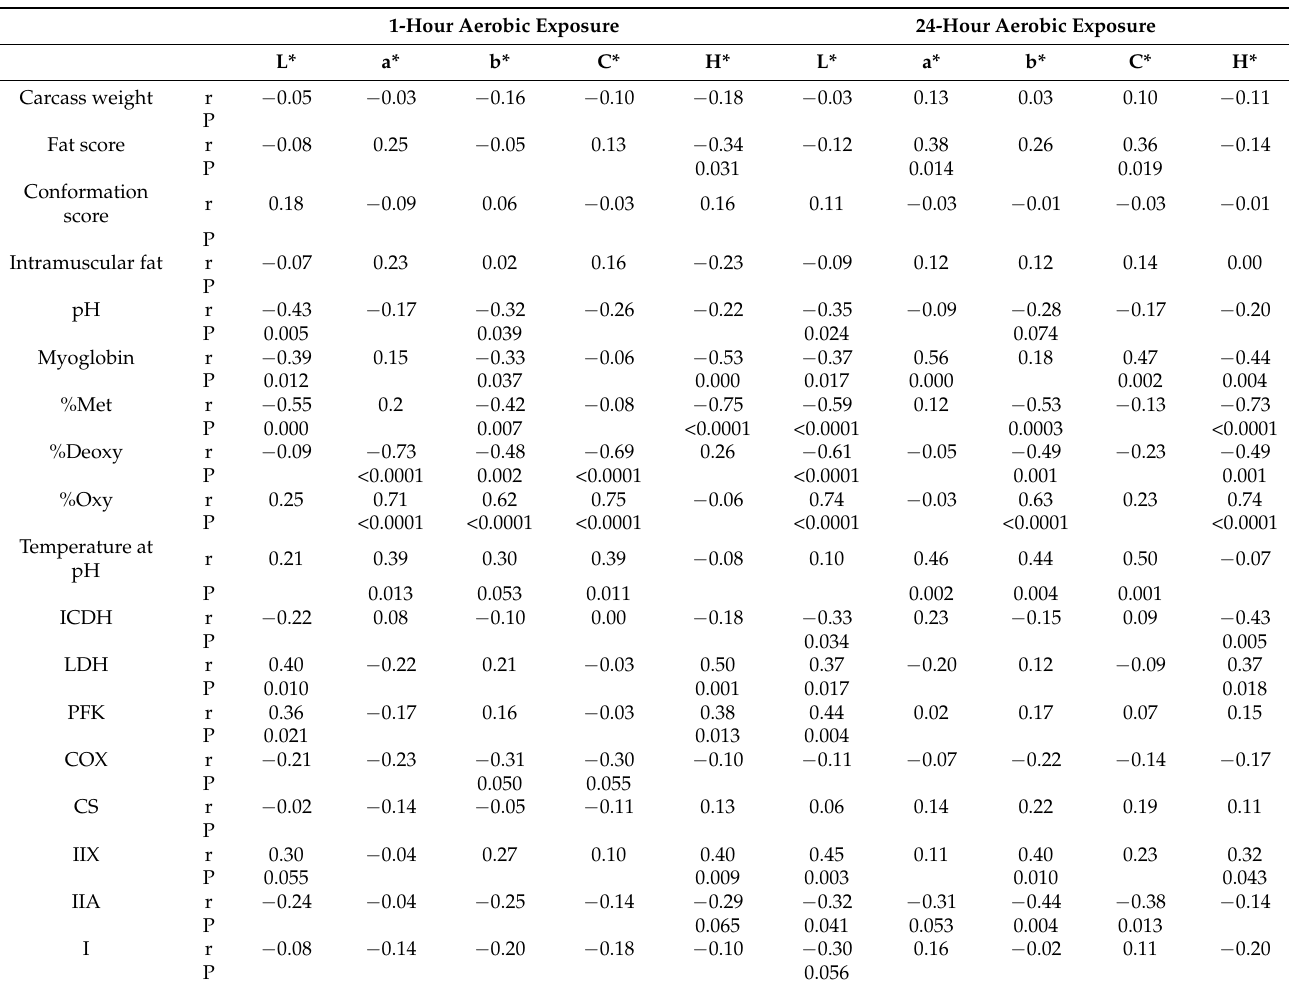
Table 6. Correlations between carcass and muscle characteristics and muscle colour after adjustment for treatments